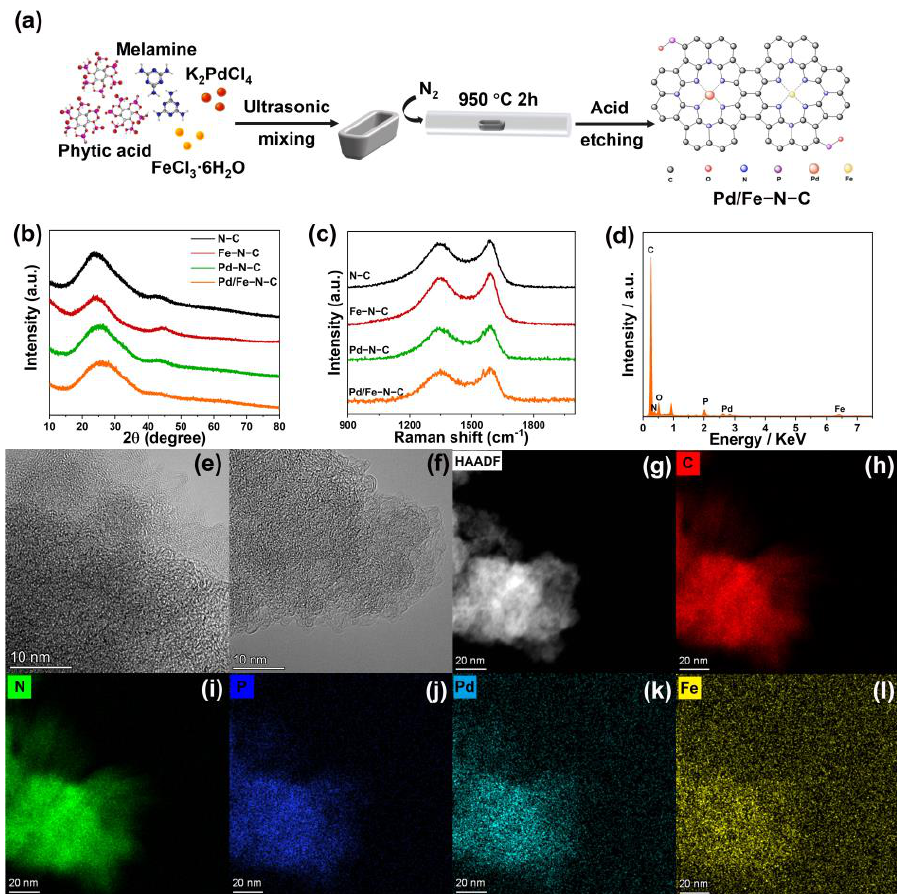
Figure 1. ( a ) Schematic illustration of the synthesis process of Pd/Fe−N−C catalysts. ( b ) XRD patterns and ( c ) Raman spectra of N−C, Fe−N−C, Pd−N−C, and Pd/Fe−N−C. ( d ) EDS of Pd/Fe−N−C. ( e , f ) High-resolution TEM, ( g ) HAADF-STEM, and ( h – l ) EDS element mapping of Pd/Fe−N−C. The XPS technique can characterize the elemental composition as well as the valence.